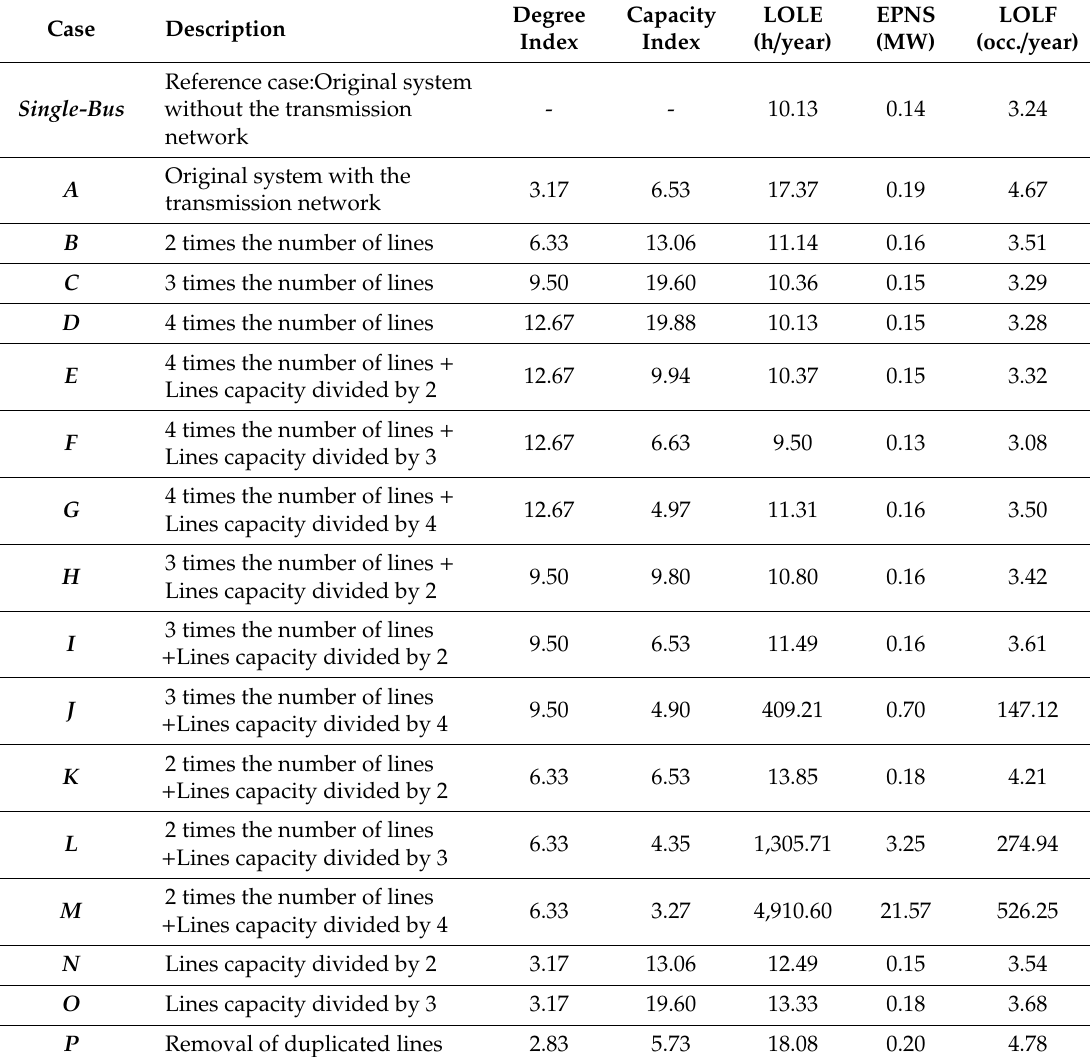
Table 1. Transmission Network Metrics and Reliability